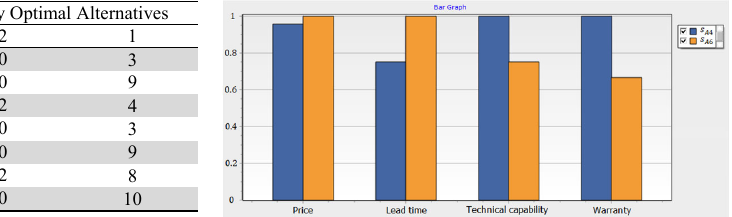
at the beginning of the (cid:3002)(cid:2869)